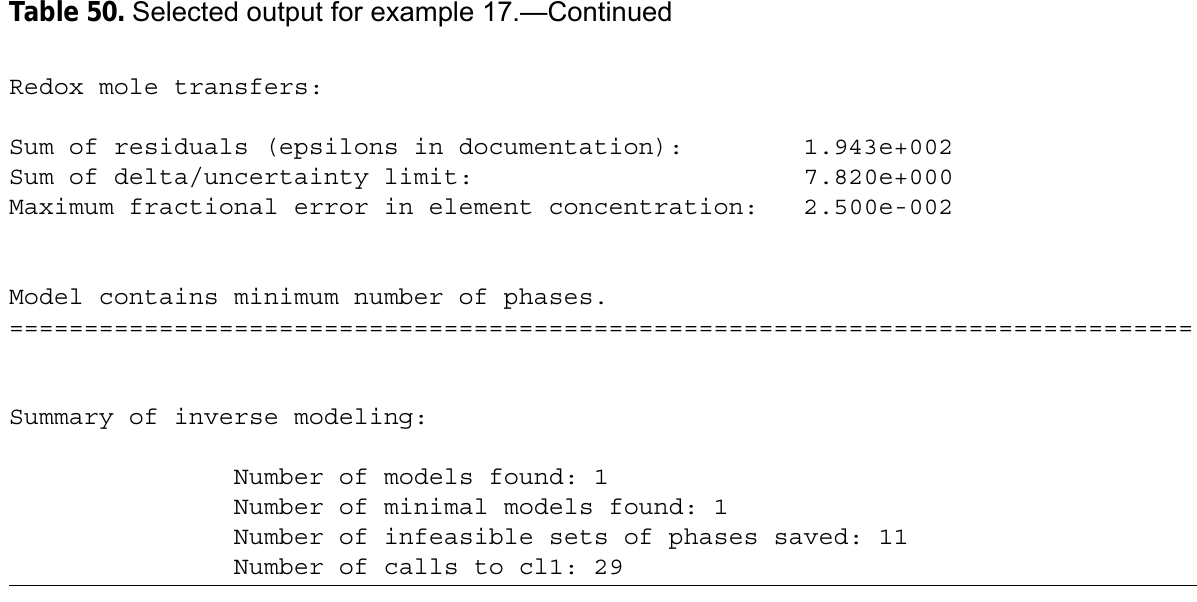
Table 50. Selected output for example 17.—Continued